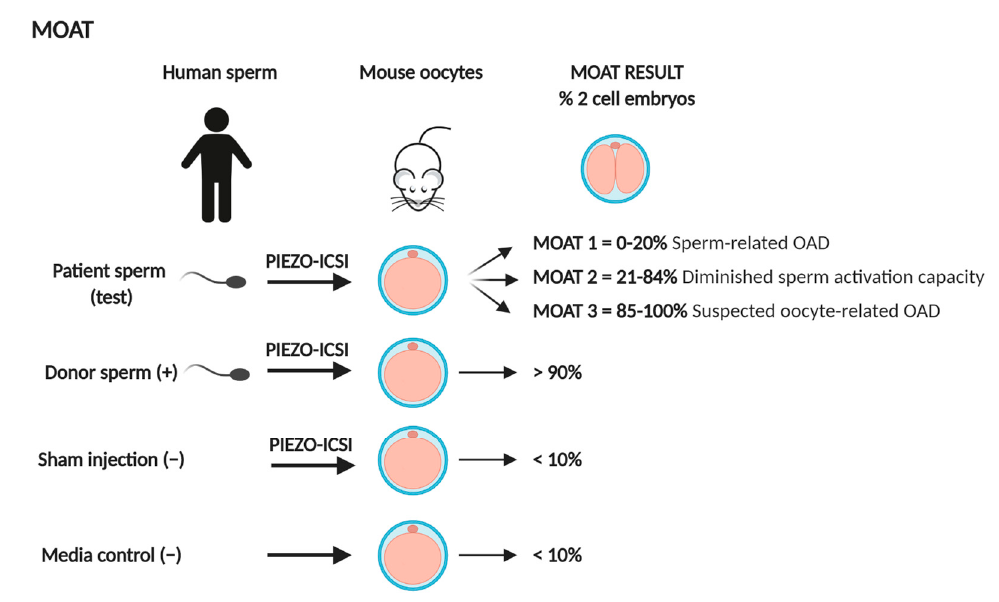
Figure 2. Schematic representation of the mouse oocyte activation test (MOAT). ( + ): Positive control group ( − ): Negative control group; PIEZO-ICSI: Piezo-assisted intracytoplasmic sperm injection; OAD: oocyte activation deficiency.